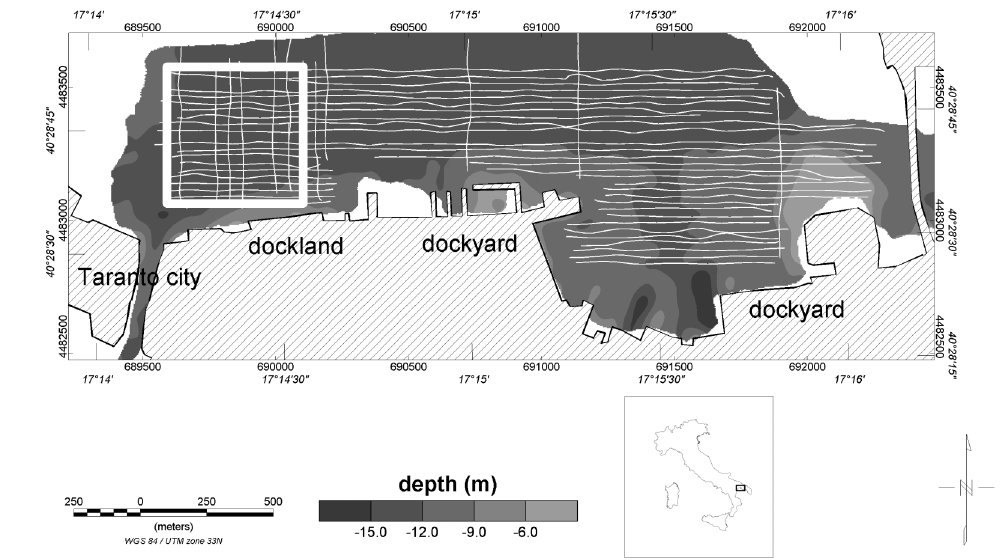
Fig. 1. Bathymetry of the survey area, main harbour infrastructure. The Taranto harbour is located on the south- eastern coast of Italy, approximately in the middle of the box on the bottom right map. The survey extent lines and ties path are indicated in white; in the boxed region on the left, all the horizontal components of the mag- netic gradient are measured and the AS is evaluated.